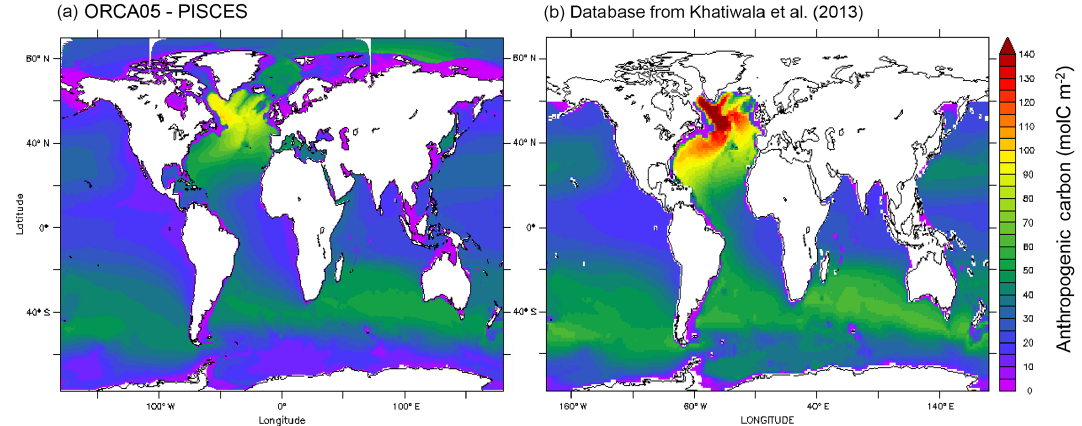
Figure 1. Column inventory (molCm − 2 ) of anthropogenic carbon for the year 2010: (a) model output and (b) Khatiwala et al. (2009).